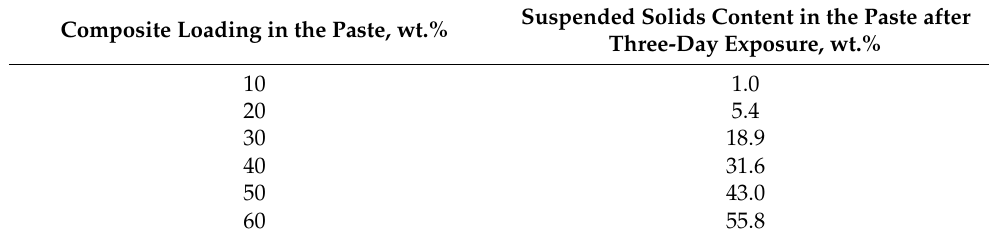
Table 1. Changes in NiO/YSZ loading after exposing pastes for three days. Composite Loading in the Paste, wt.%